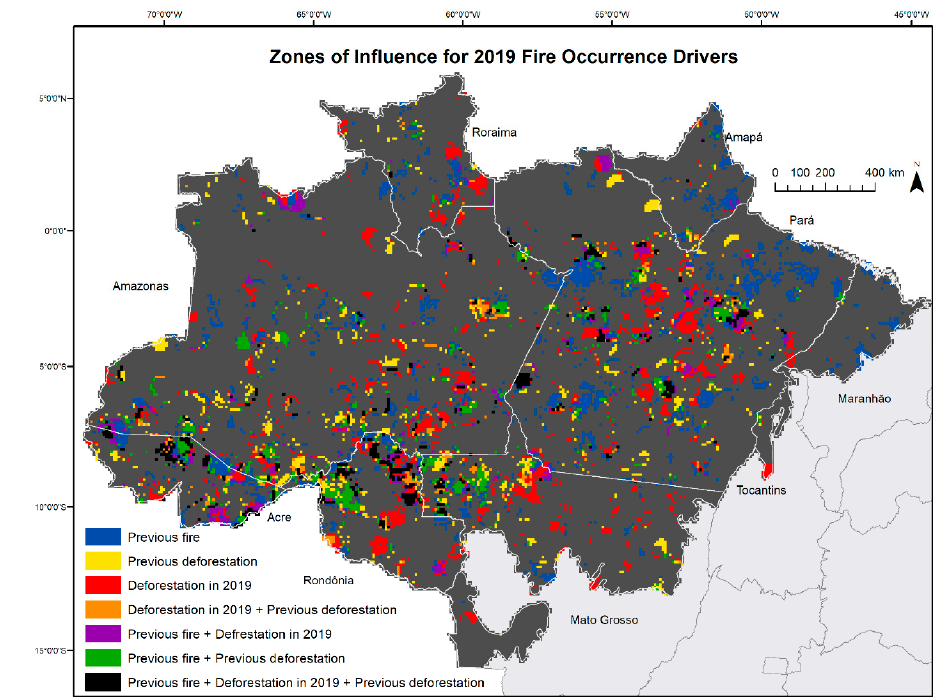
Figure 7. Each 10 km pixel in this map represents a statistically significant relationship of a